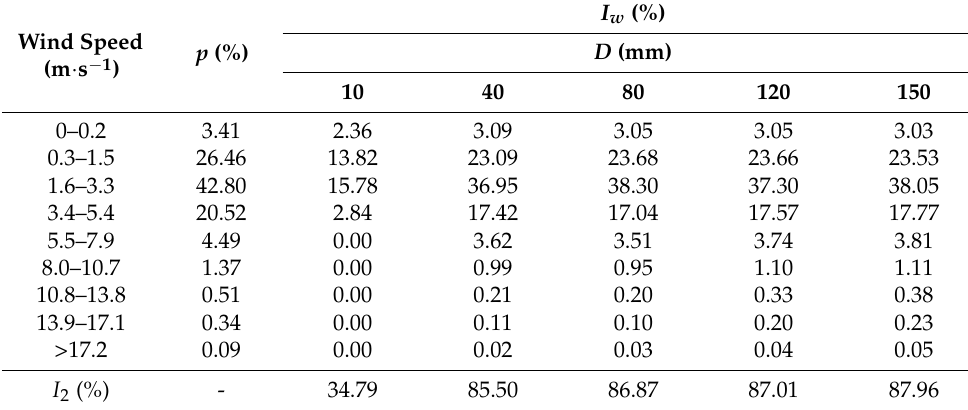
Table 8. ESEs of fence and floating balls at different wind speeds.